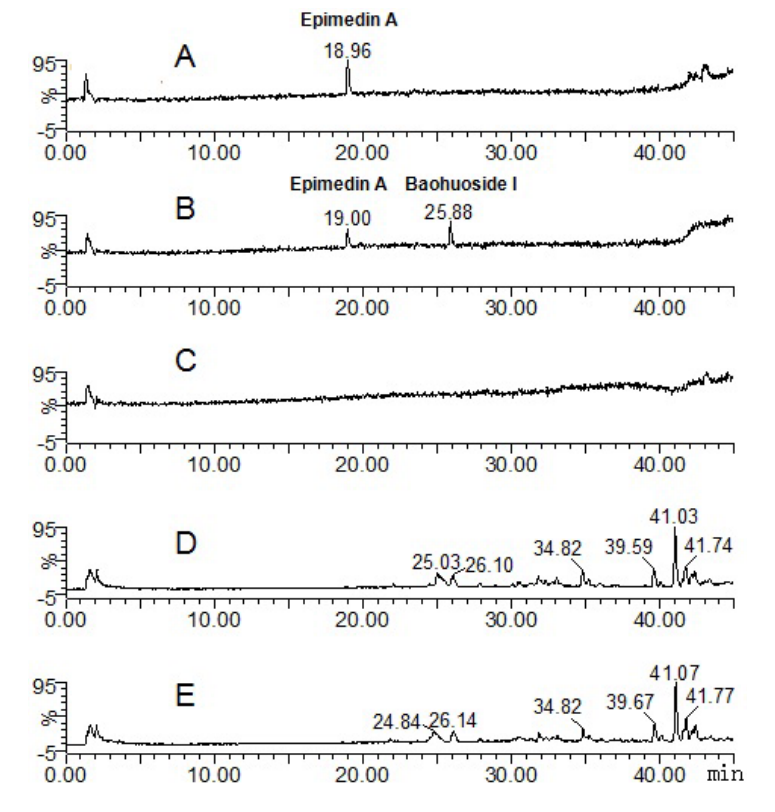
Figure 5. Mass spectrometry total ion current chromatograph for the epimedin A groups after 24 h (negative mode). A : epimedin A solution; B : epimedin A zebrafish group solution; C : blank zebrafish group solution; D : zebrafish of epimedin A zebrafish group; E : zebrafish of the blank zebrafish